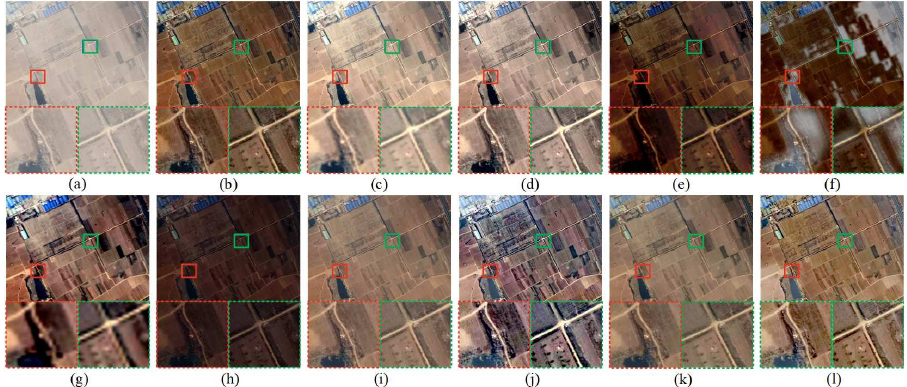
Figure 9. Dehazing example 3 of a remote sensing image from a real hazy scene: ( a ) Original; ( b ) DCP; ( c ) GPR; ( d ) AMP; ( e ) DEFADE; ( f ) WCD; ( g ) RRO; ( h ) MOF; ( i ) CAP; ( j ) HLM; ( k ) DN; ( l ) Proposed. Two partially enlarged images marked in red and green dotted frames correspond to the regions surrounded by red and green frames in the dehazed image.